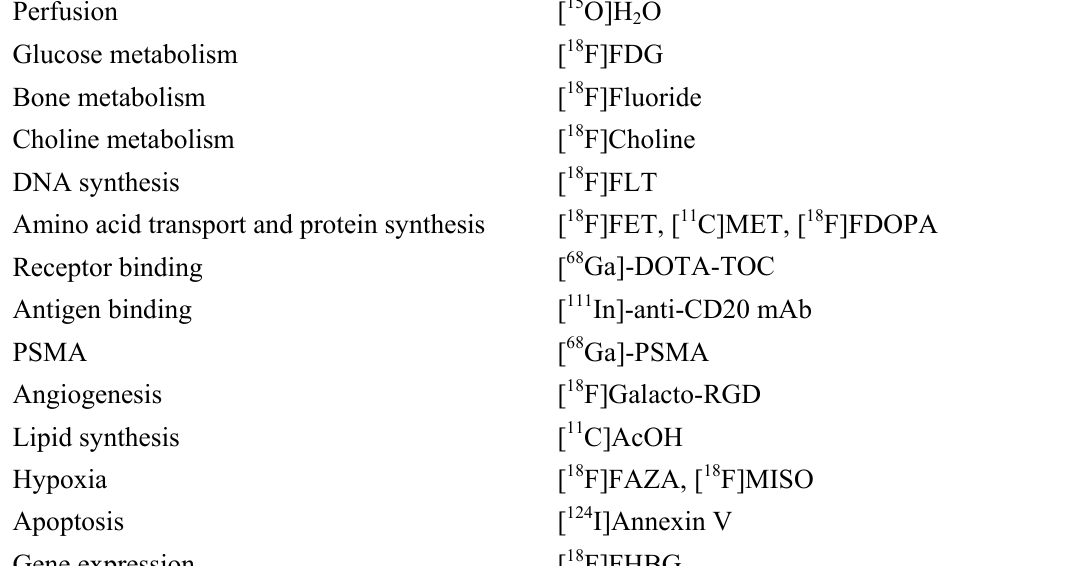
Table 1. Biomarkers used in clinical routine for tumor-diagnosis